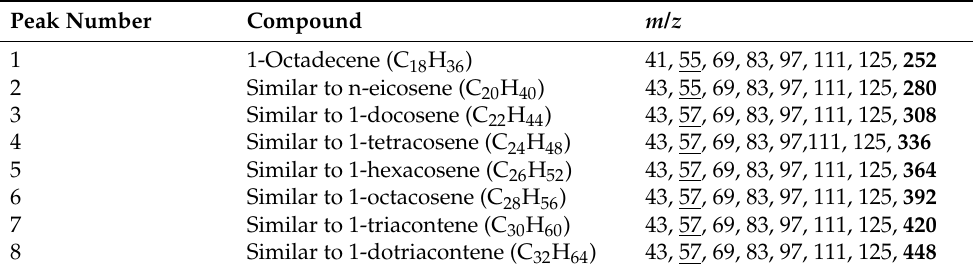
Table 2. Volatile organic compounds detected in the red lids 1 and 2 (characteristic ions in mass spectra: molecular weight, M w , in bold and base peak